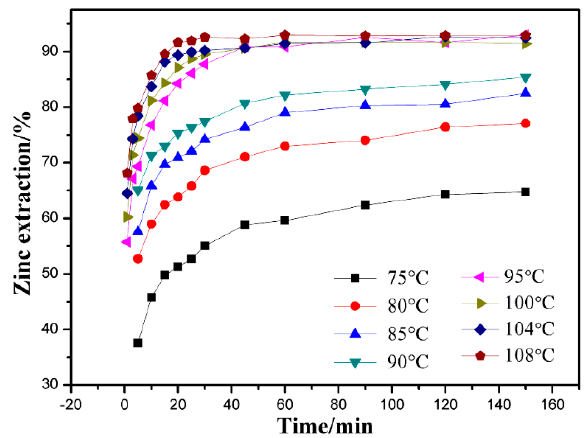
Figure 2. The effect of leaching temperature on zinc extraction (5.0 mol/L NH 4 Cl; solid/liquid